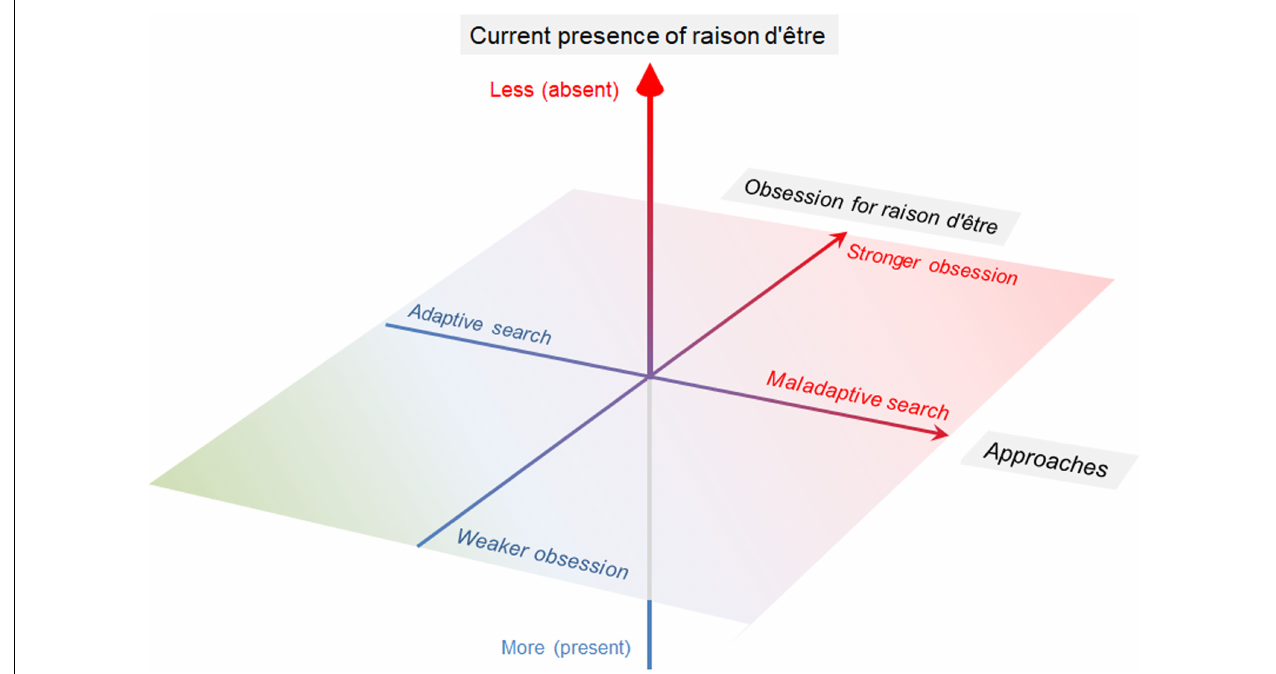
FIGURE 1 | Theoretical three major components of psychological problems relating to raison d’être. The proposed three major components of the psychological problems regarding raison d’être in the present report are as follows: deficiency of raison d’être, levels of obsession with it, and maladaptive search processes. By regarding these three major components as continuous variables and not simple binomials, psychological status in each individual can be represented as a spectrum with wide variation of the psychological